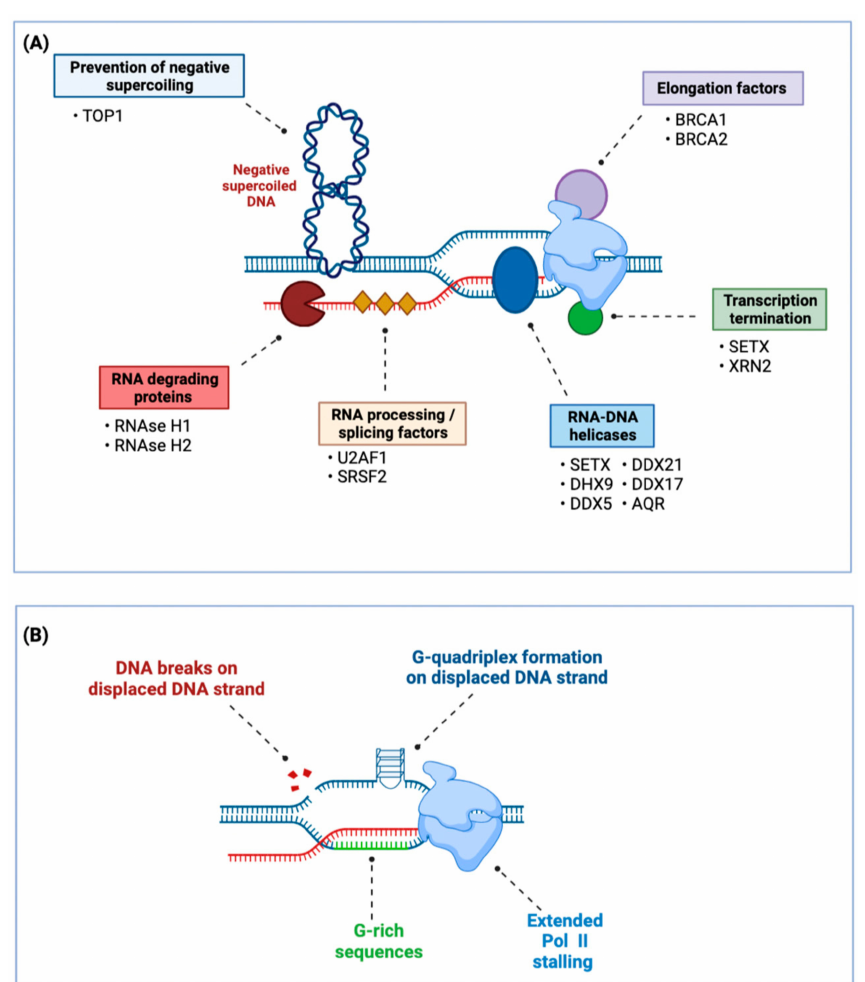
Figure 2. R-loop resolution and formation in the cell. ( A ) Prevention and resolution of R-loops. TOP1 unwinds negative supercoiling resulting from strand unwinding during transcription and thereby prevents mRNA from annealing to unwound DNA, thereby preventing R-loop formation [29]. RNA processing and/or splicing factors such as SRSF2 and U2AF1 prevent R-loop formation by coating of the nascent mRNA transcript and thereby preventing annealing to the template strand [30,31]. BRCA1 and BRCA2 prevent Pol II stalling and promote transcription elongation by acting as elongation factors, thereby preventing R-loop formation by ensuring processive transcription [32–34]. SETX and XRN2 signal Pol II termination, which prevents R-loop formation due to prolonged Pol II stalling [19]. Once formed, aberrant R-loops can be resolved through degradation of the RNA component by RNAse H1 or H2, which specifically degrade RNA-DNA hybrids. R-loops can also be resolved by unwinding the RNA-DNA hybrid through the helicase activity of SETX, DHX9, DDX5, DDX17, DDX21, and AQR [1,20,21]; ( B ) Physiological and pathological processes that promote R-loop formation. R-loops preferentially form when Pol II is stalling. This can be caused by DNA damage, structural hindrance through G-quadruplex formation, or tighter base-pairing in GC-rich sequences [1]. TOP1 (transient breaking and rejoining of single-stranded DNA): Topoisomerase I; SRSF2 (RNA-binding protein): serine and arginine rich splicing factor 2; U2AF1 (splicing factor): U2 small nuclear RNA auxiliary factor 1; SETX (helicase): Senataxin; XRN2 (DNA incision): 5 (cid:48) -3 (cid:48) exoribonuclease 2; DHX9 (helicase): DEAD box helicase 9; DDX5 (helicase): DEAD Box helicase 5; DDX17 (helicase): DEAD Box helicase 17; DDX21 (helicase): DEAD Box helicase 21; AQR (pre-mRNA splicing): RNA helicase aquarius; Pol II (DNA transcription): RNA polymerase